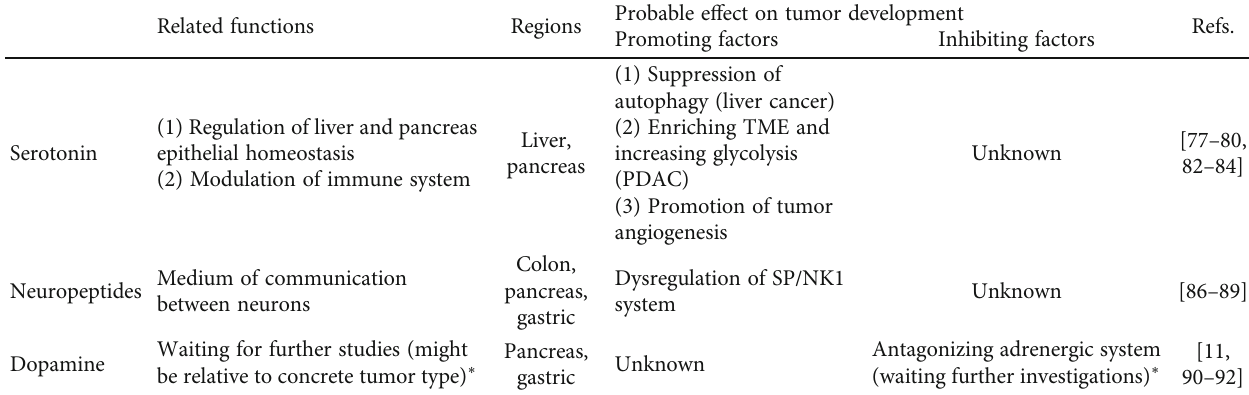
Table 1: A comparison between serotonin, neuropeptides, and